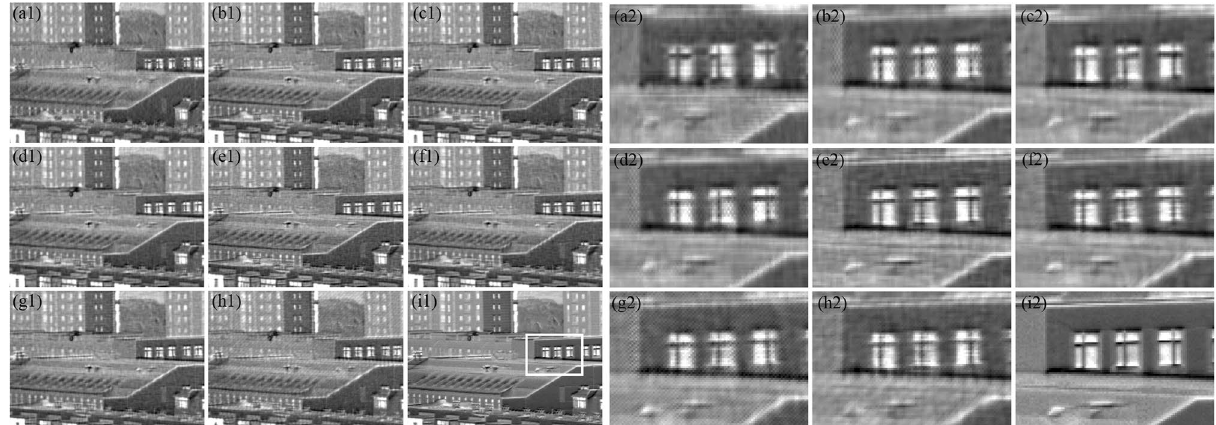
Figure 3. Reconstructed DoLP images of different MPA patterns on the building1 scene. The left side represents the ( a1 ) 2 × 2, ( b1 ) 2 × 4, ( c1 ) 2 × 3, ( d1 ) 2 × 7, ( e1 ) 2 × 2 × 2, ( f1 ) 3 × 3, ( g1 ) 5 × 5, ( h1 ) 7 × 7, and ( i1 ) ground-truth. The right side gives the enlarged views of white rectangular regions of the reconstructed images and ground-truth image according to MPAs in the left side.